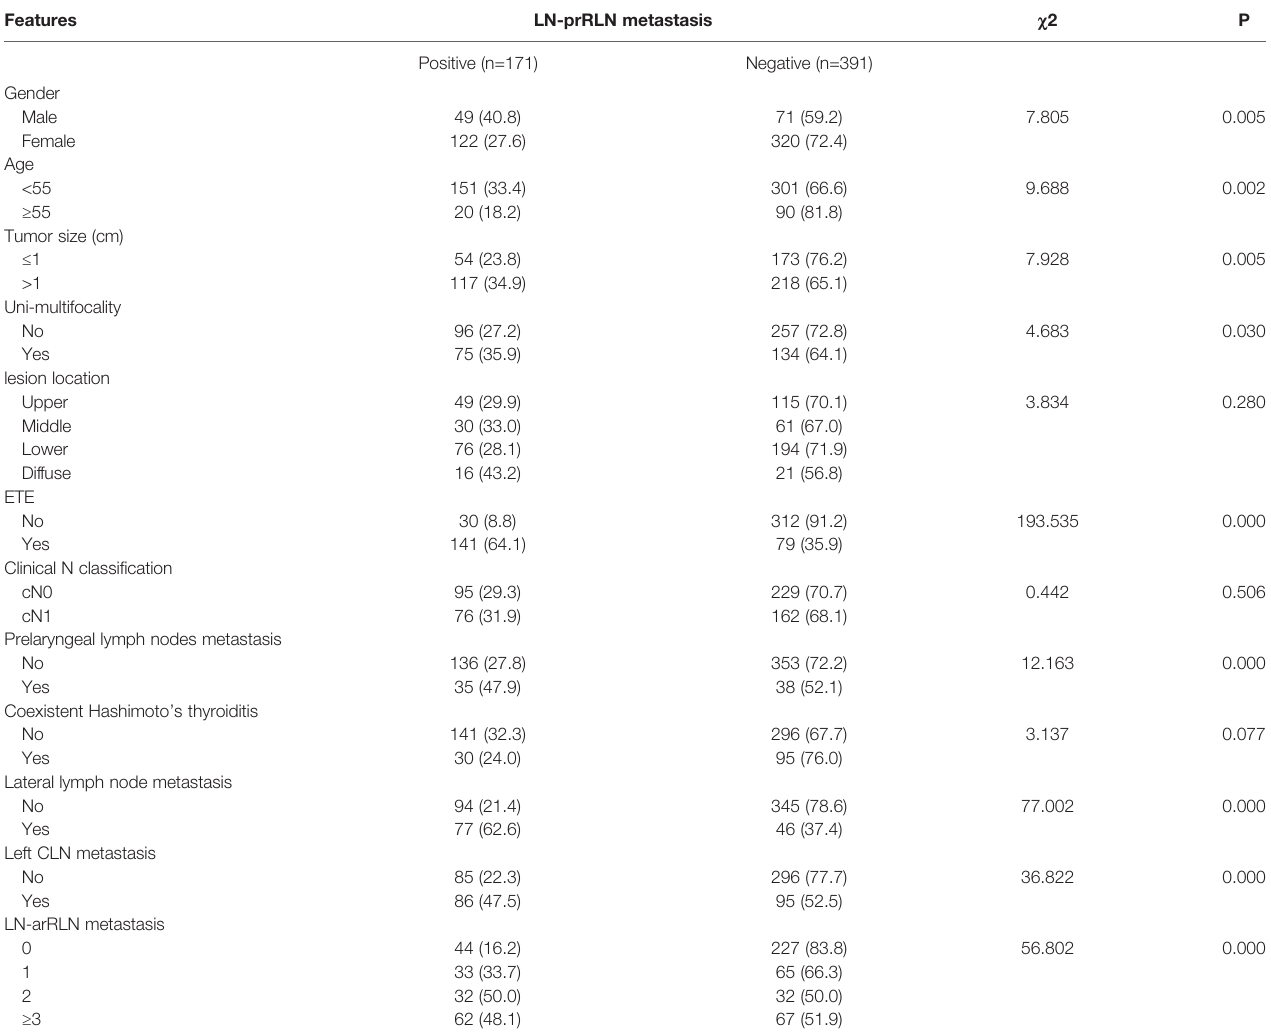
TABLE 5 | Univariate analysis of predictor for lymph node posterior to the right recurrent laryngeal nerve (LN-prRLN).